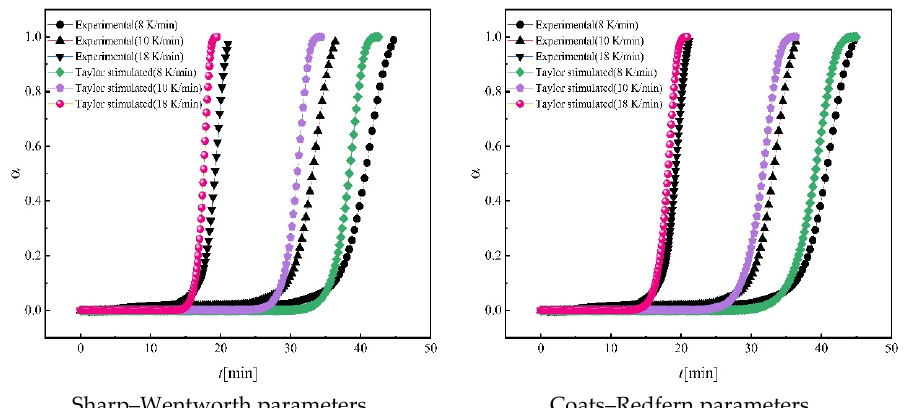
Figure 6. Experi mental and predicted data using Sharp–Wentworth and Coats–Redfern parameters of Fe 2 O 3 → Fe 3 O 4 using the explicit Euler method.